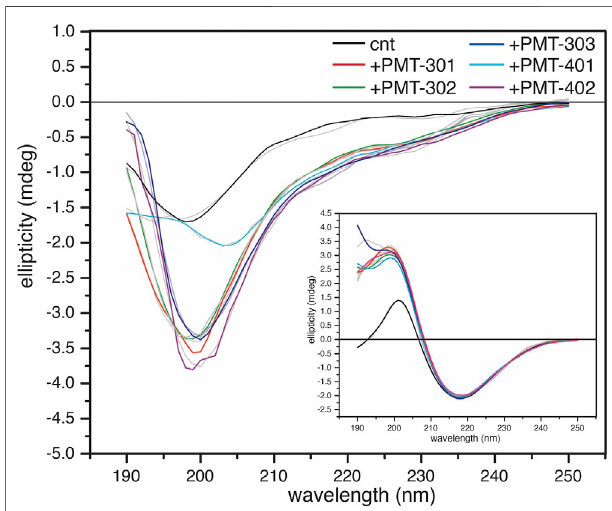
FIGURE 5 | CD spectra of A β Os treated with a stoichiometric amount of PALagent.CDspectraof1-hA β Otreatedwith40 μ MPAL.Thecontrol(black) wastreated with an equal volume of vehicle. The inset shows the high β -sheet structure fi brillar oligomers show little structural response to the PAL agents. BeStSel fi ts of the spectra are given in light gray lines.